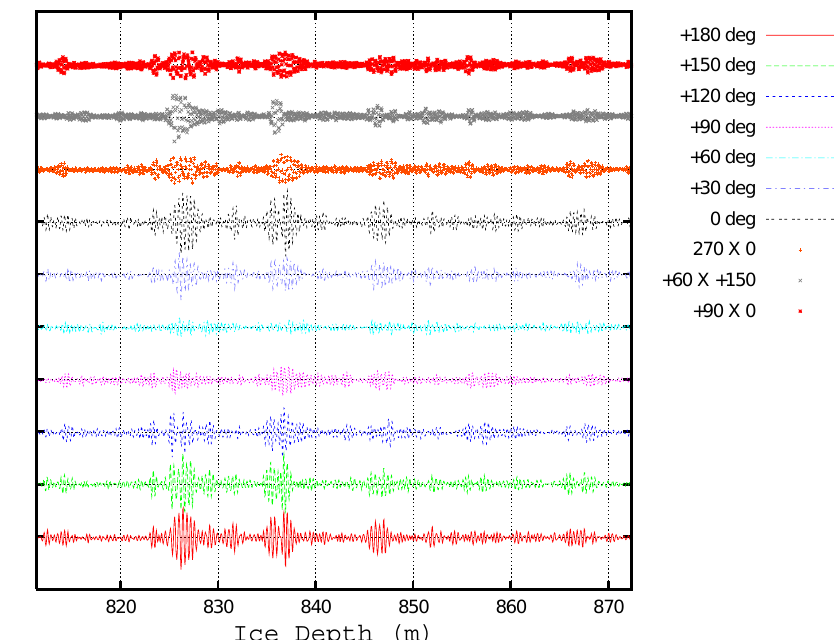
Fig. 6. Zoom of interval around 9.6µs, converted to depth. Vertical divisions correspond to 5mV. No horizontal offset has been applied to successive waveforms. Each 10 meter division horizontally corresponds to approximately